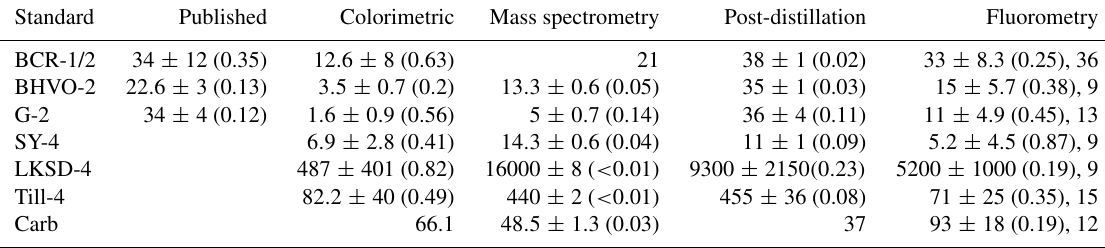
Table 3. Nitrogen from all three techniques (mass spectrometry, colorimetry, and fluorometry) compared to published values from NAA. Shown is the mean with standard deviation and coefficient of variation in parentheses. The values after the commas in the Fluorometry column represent the number of separate measurements for non-distilled samples. All concentrations are in parts per million.